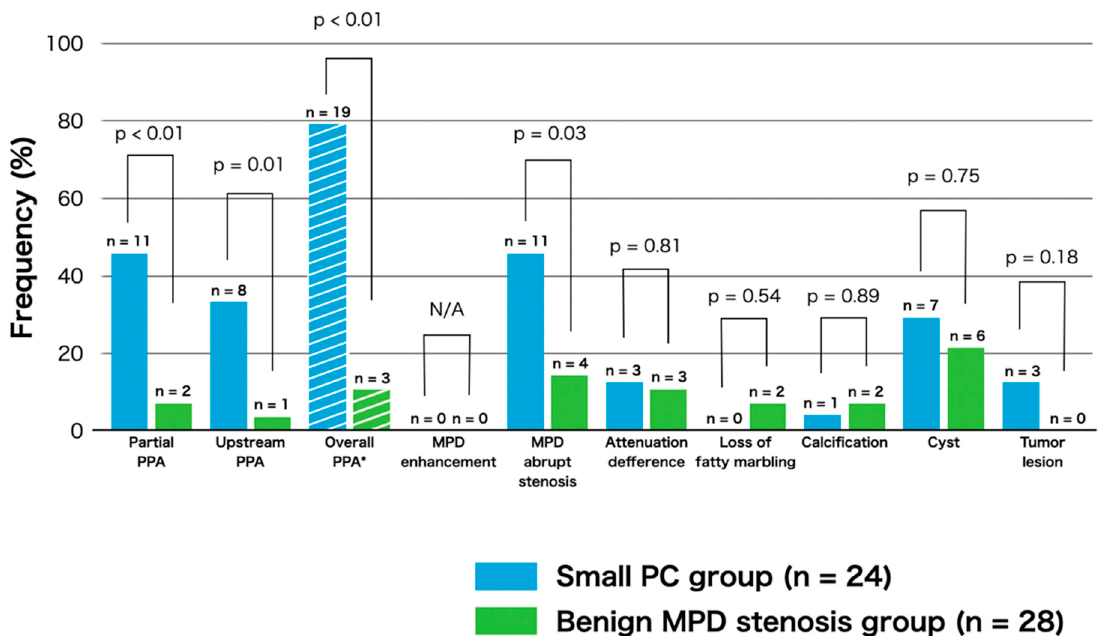
Figure 5. The proportions of patients exhibiting computed tomography findings in the small pancreatic cancer and benign main pancreatic stenosis groups. * Overall PPA was defined as the combination of partial and upstream PPA.